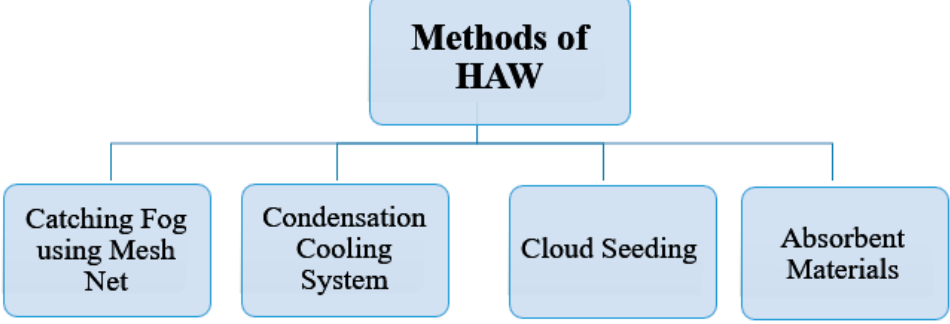
Figure 2. Harvesting atmospheric water methods.